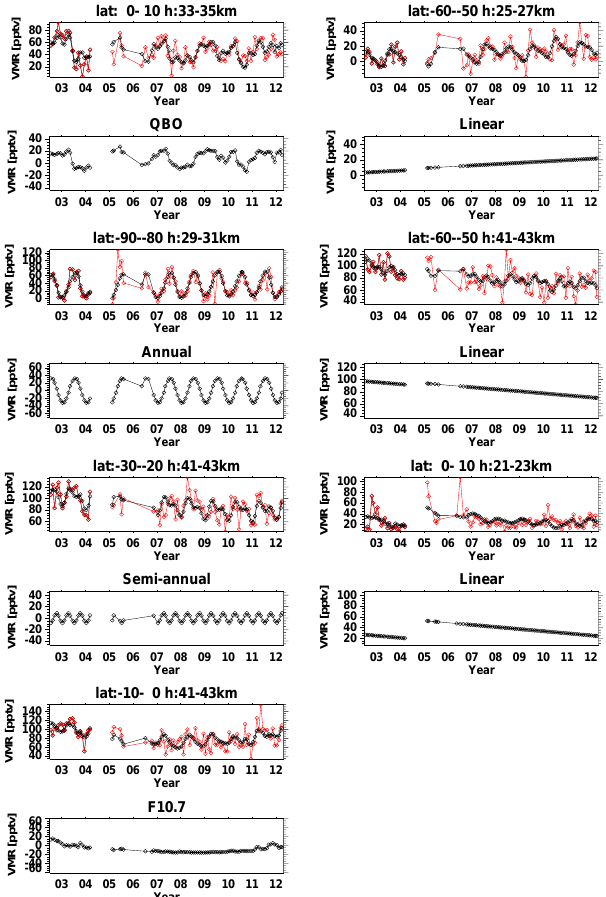
Fig. 14. Time series of multivariate fit results illustrating prominent parameters at different latitude/height regions. Marks along the x axes indicate 1 January of each year. For each parameter, two plots are grouped together: the upper one contains the measured dataset in red and the fit in black for the region as specified in the title; the lower plot illustrates the separate weight of the dedicated parameter listed in the title. Left, rows 1 and 2, linear combination of Singa- pore winds at 10 and 50hPa; left, rows 3 and 4, annual variation; left, rows 5 and 6, semi-annual variation; left, rows 7 and 8, solar F 10 . 7 flux; right column, linear trend and bias.